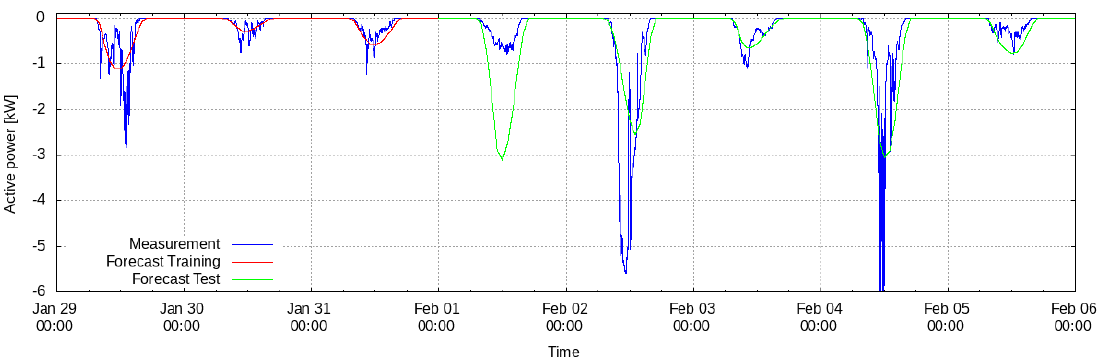
Figure 4. Ground truth and prediction by a polynomial model of degree two for the energy generation at the photovoltaic plant without